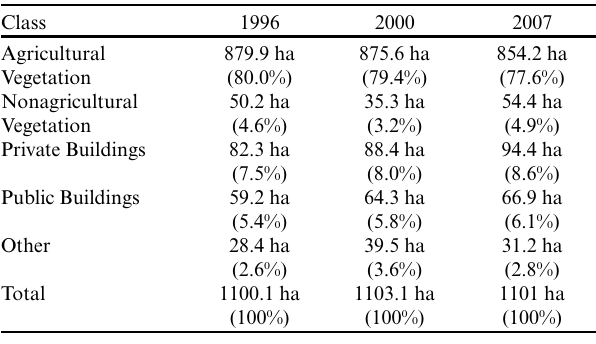
Table 2 . Summary statistics of the five land-use classes as mapped in 1996, 2000, and 2007 as a part of the Chitwan Valley Family Study. Listed first in each cell is the land area in hectares (summed across all neighborhoods) within that class. Listed in parentheses is the percentage of total land area in each class. Note that the total changes slightly between years; this is due not to differences in neighborhood size but rather to the margin of error in the neighborhood mapping data.